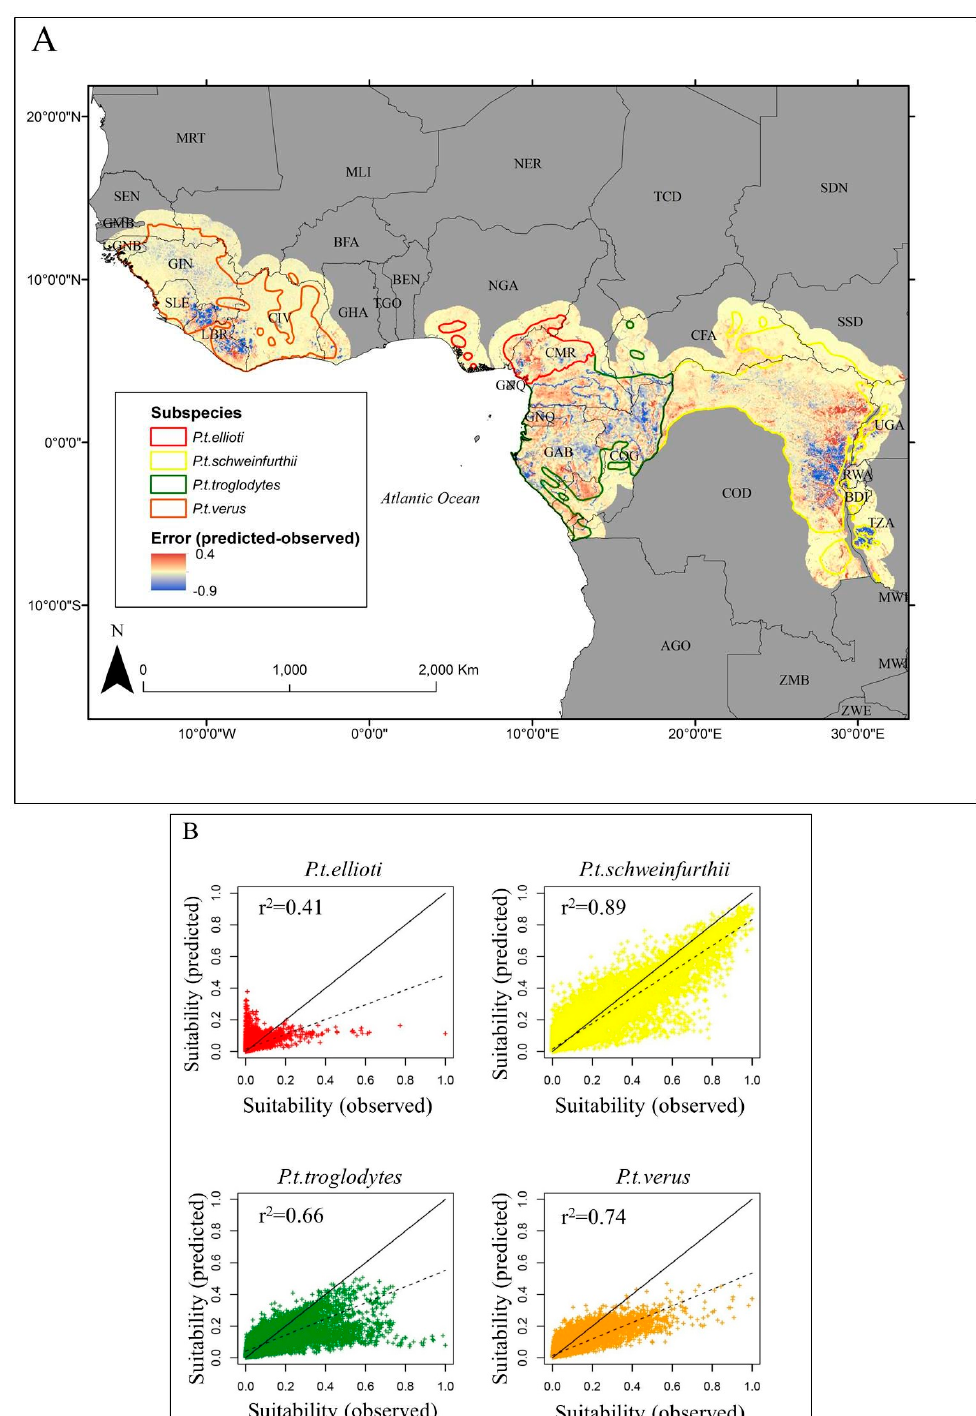
Figure 5. Spatial distribution of differences between the 5-km resolution map used for model calibration and the 30-m map after coarsening to 5-km resolution ( A ), distribution of suitability values of 5-km calibration map (x-axis) and coarsened 30-m map (y-axis) for each sub-species ( B ). The one-to-one line is shown in solid black and results of regressing values from the coarsened 30-m map onto values from the 5-km map for each sub-species are shown by the dashed black line.